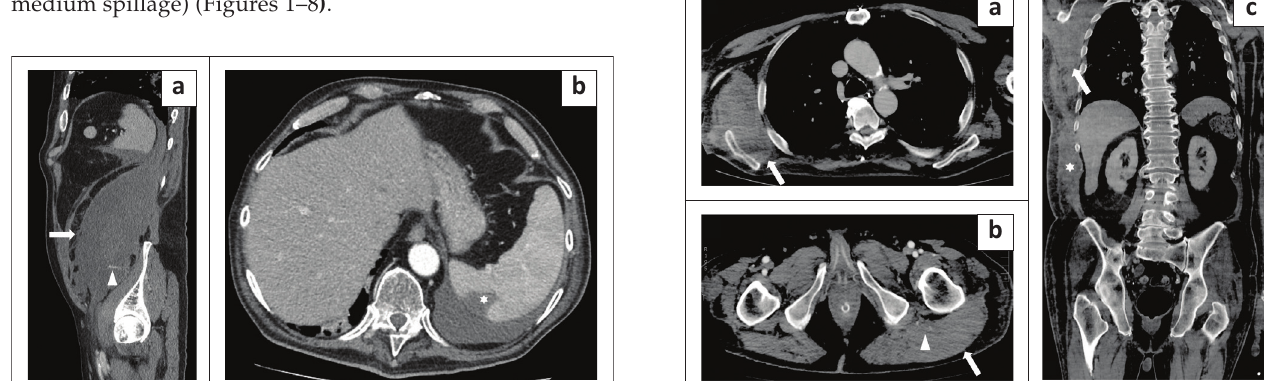
FIGURE 1: A 65-year-old man with a retroperitoneal haematoma in the left iliopsoas muscle, diagnosed 17 days after hospital admission. (a) Parasagittal plane, arterial phase: a contrast blush (arrowhead) can be seen in the lower part of the haematoma (arrow). (b) Axial plane, venous phase: the patient later developed a minor splenic infarct (asterisk). The patient underwent endovascular embolisation and survived.